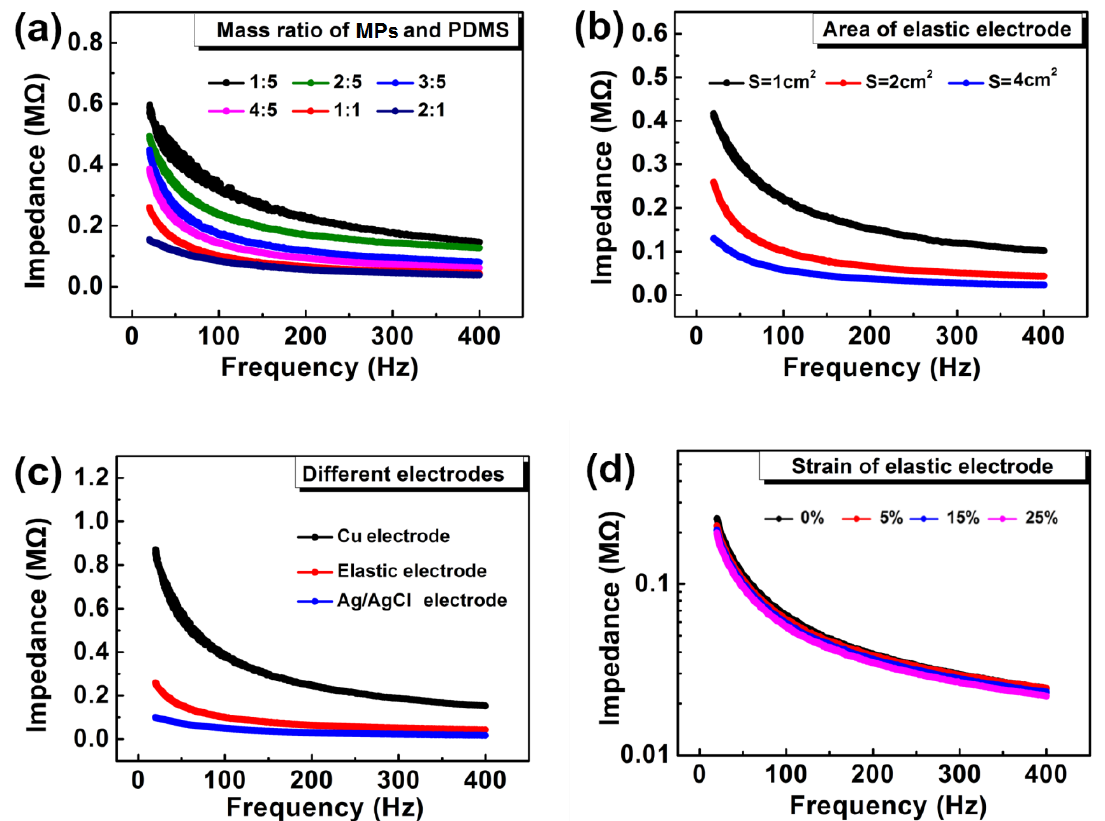
Figure 4. Electrode–skin impedance tests of sEMG electrode: ( a ) Impedance variation w.r.t change in MPs:PDMS mass ratio. ( b ) Effect of electrode area on impedance of electrode. ( c ) Impedance comparison of various electrodes. Cross-sectional area of all electrodes is the same (i.e., 2 cm 2 ). ( d ) Impedance performance of our elastic electrode (2 cm 2 ) under different tensile strains.